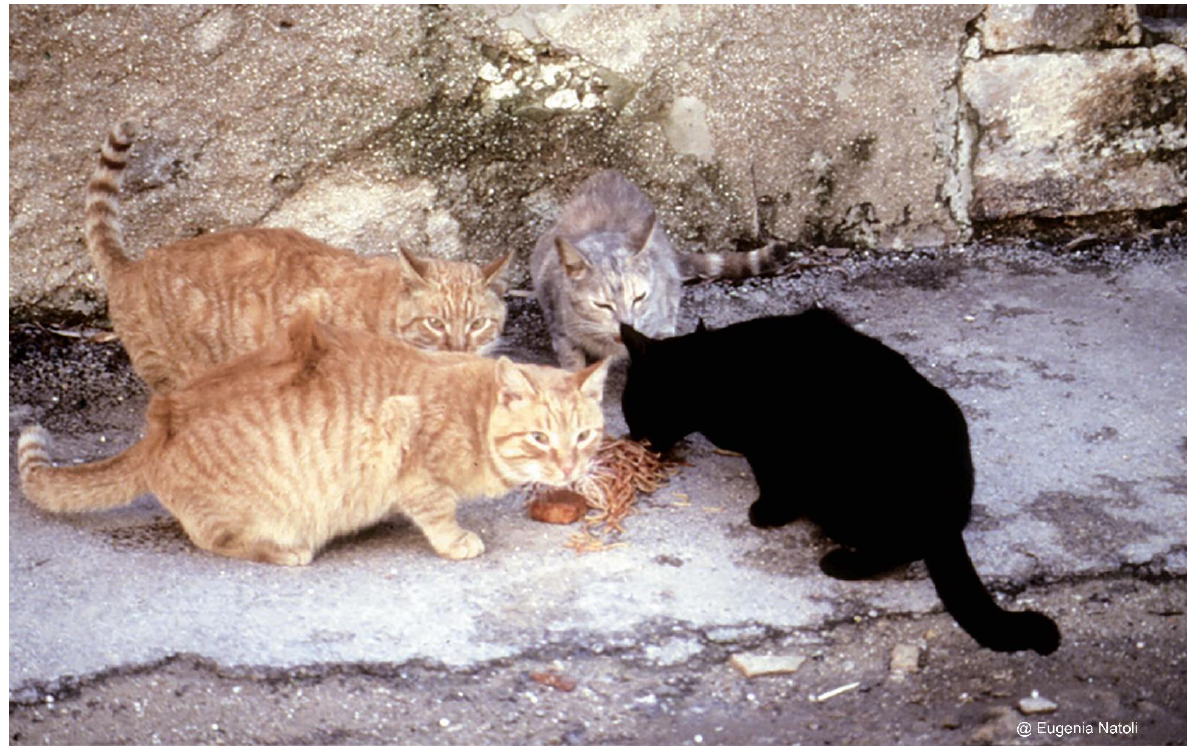
Figure 2. Adult cats living in group in a Sicilian town; they are eating pasta (credit Eugenia Natoli). The rural cat lives in an intermediate situation, typically within a human dwelling or property, with a relatively low density (about 250 individuals per km 2 , [13]) in small groups.